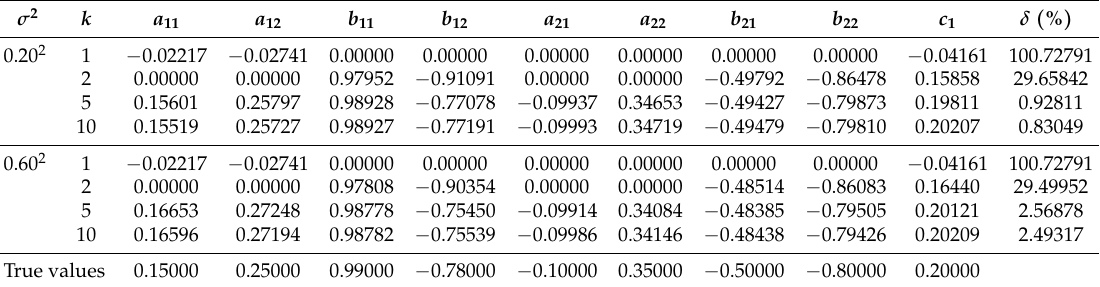
Table 2. The F-LSI parameter estimates and errors for Example 1 ( L = 2000).